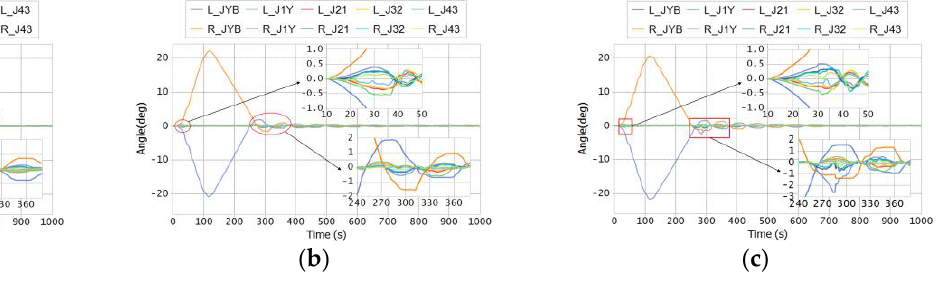
Figure 12. Rotation angles of TSHs in orbit maneuver: ( a ) by rigid body; ( b ) by MORM; ( c ) by FEM. Generally, the satellite was steered successfully by every approach. Except for the R_JYB and L_JYB, all the other TSHs were locked well at the beginning of the steering since the maximum rotation angles of the TSHs were about 0.5 ◦ . According to the stiffness spline of TSH shown in Figure 4, the highest stiffness came about at 1.5 ◦ . The rotation angles of the R_JYB and L_JYB were slight larger than 20 ◦ , and there was not much difference in the rigid body model, MORM model and FEM model. Although the steering stopped at 130 s, it took about 230 s for the rotation angles of the R_JYB and L_JYB returning to 0 ◦ , as shown by the enlarged parts of the Figure 12a–c. The panels were rotated symmetrically in the rigid body model; the L_JYB returned to 0 ◦ earlier than the R_JYB in the MORM model; while the R_JYB returned to 0 ◦ earlier than the L_JYB in the FEM model. Therefore, the rotation angles were not symmetric in either the MORM or the FEM model. All the rotation angles were limited to the range of − 2 ◦ to 2 ◦ in the MORM model. However, the rotation angle of R_J1Y exceeded 2 ◦ and had the tendency to break up the locking condition in the FEM model. Additionally, the rotation angles were changed smoothly in the MORM model, while much vibration was generated in the rotation angles of FEM